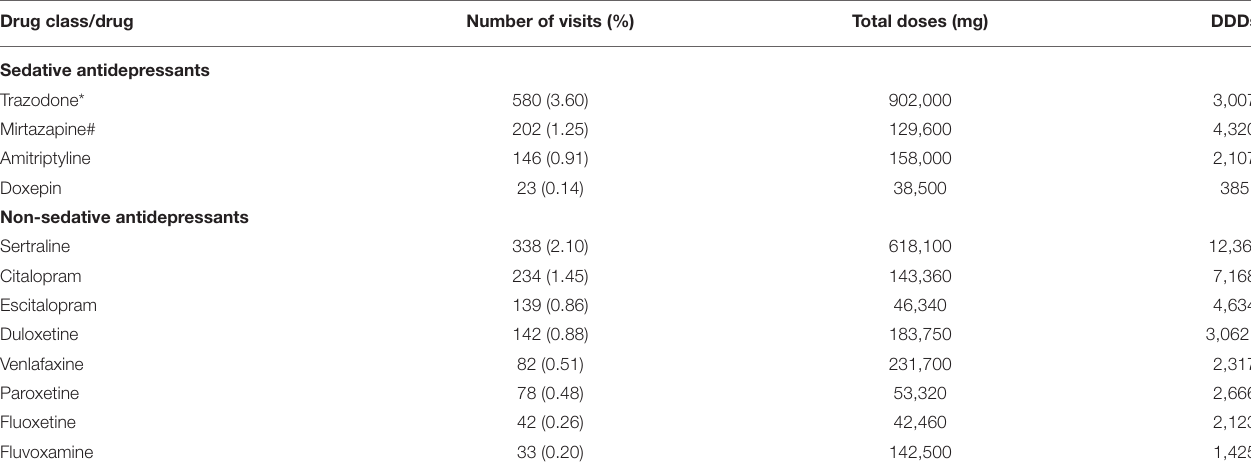
TABLE 4 | Situation of prescribed antidepressants in outpatients with insomnia. Drug